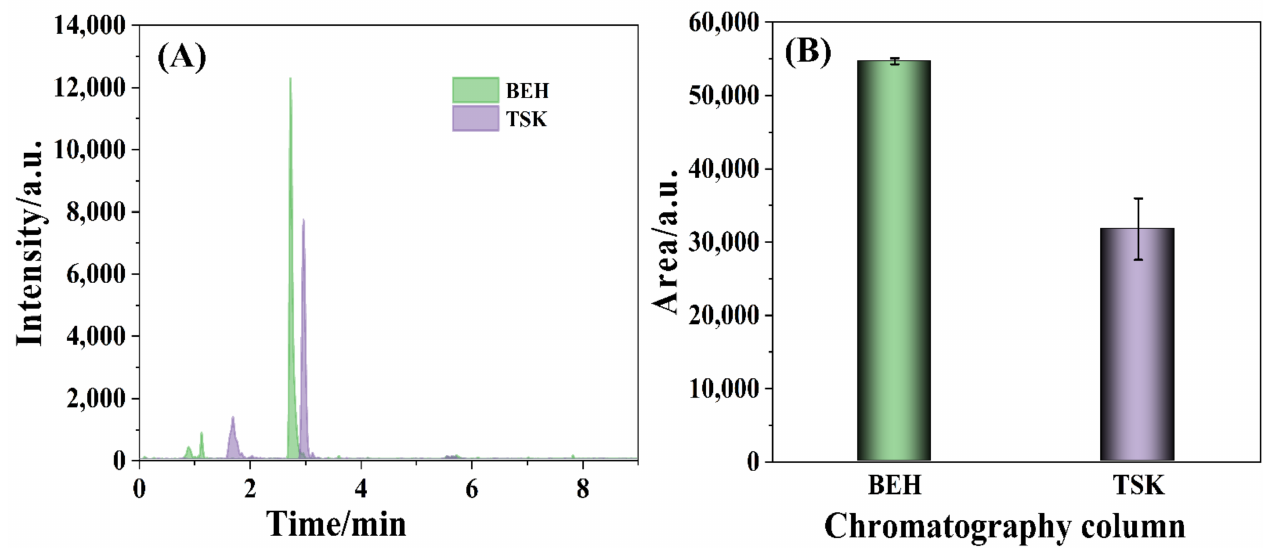
Figure 1. The chromatographic peaks ( A ) intensity and ( B ) area of the 320.2 > 302.2 m / z ion fragment detected by the BEH amide column and TSK amide column with a TTX concentration of 25